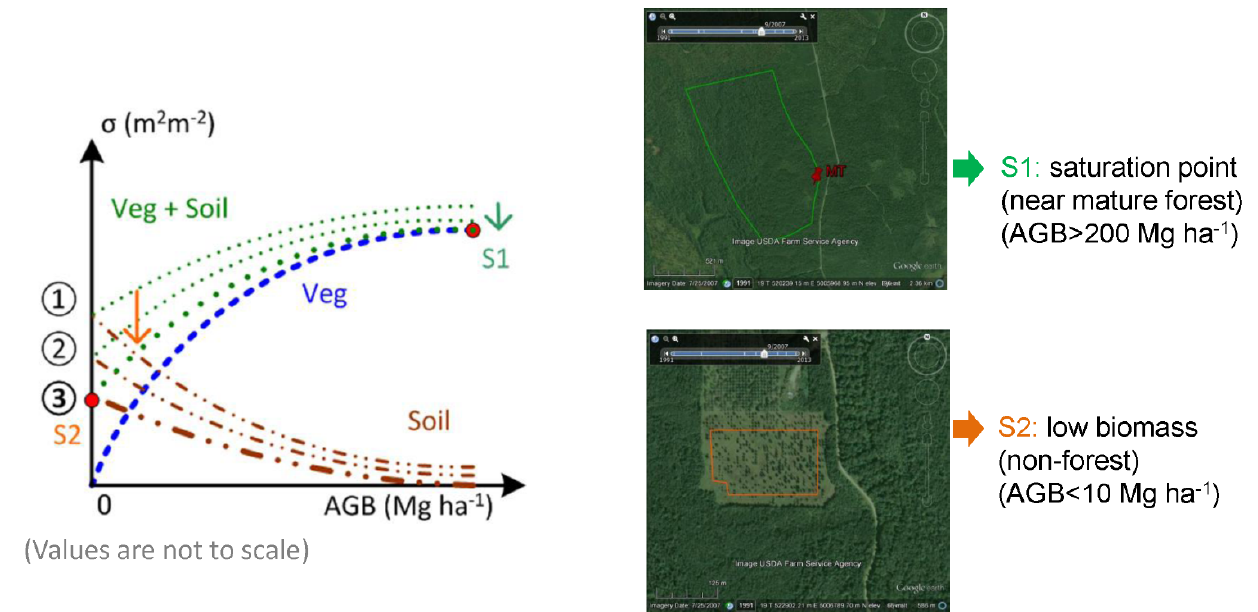
Figure 4. Conceptual diagram of cross-image normalization. Figure units are power domain (m 2 ·m − 2 ) for backscatter ( σ ), and density per hectare (Mg·ha − 1 ) for biomass; S1 is the saturation point in a near-mature forest; S2 is the maximum soil effect point in a non-forested area. Dashed blue line (Veg) is the fitted backscatter versus biomass received from vegetation canopy without soil influences in theory; Brown dashed and dotted lines are backscatter from soil surfaces. Green dotted lines are backscatter from vegetation canopy plus soil. ① – ③ denotes backscatter from data with different surface and soil moisture